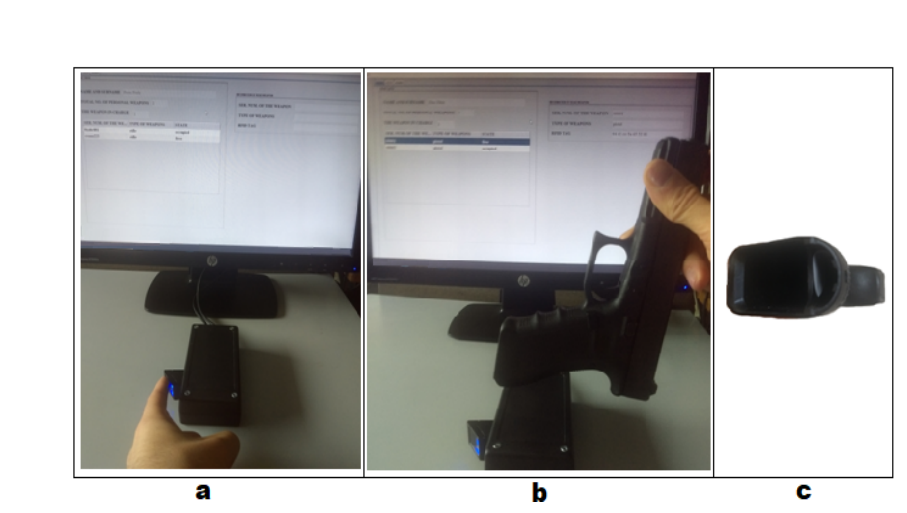
Figure 5 – Implemented solution: (a) registering, (b) weapon identification, (c) tag